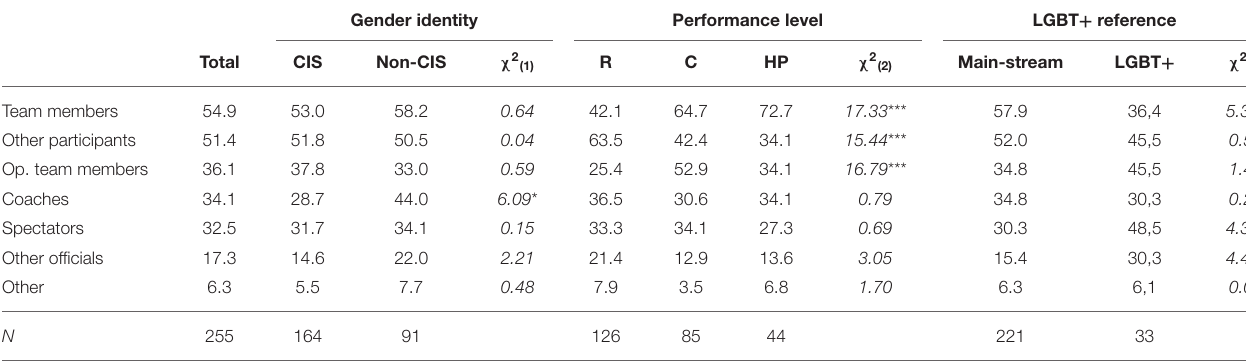
Gender identity Performance